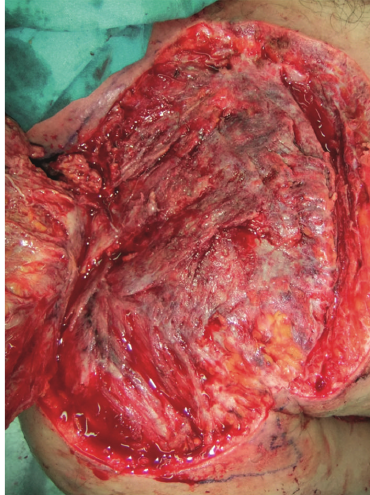
Figure 2: Intraoperative view showing the pectoralis major and deltoid muscles with fibrotic and necrotic areas. All a ff ected muscles were